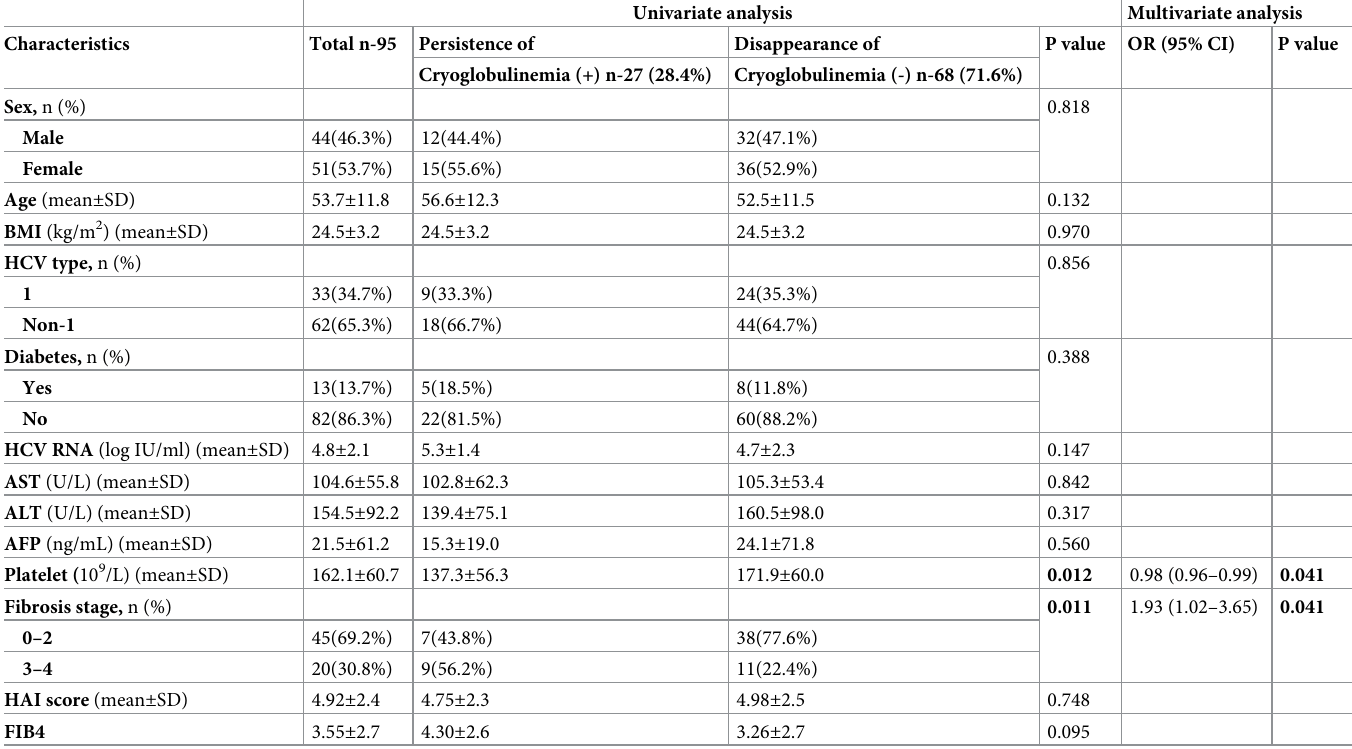
Table 3. Univariate and multivariate analysis of the factors associated with SVR in patients with follow up after antiviral